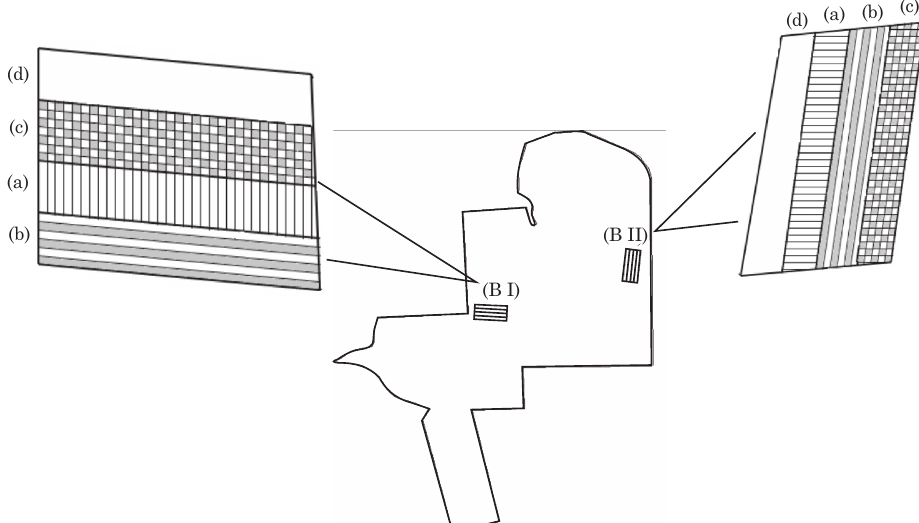
Figura 1. Localização espacial dos blocos e tratamentos na área experimental. Em que B I = Bloco I e B II = Bloco II. (a) EC = escarificador convencional; (b) ESEV = escarificador sítio-específico com profundidade de atuação variável; (c) ESEF = escarificador sítio-específico com profundidade de atuação fixa; e (d) SE = sem escarficação